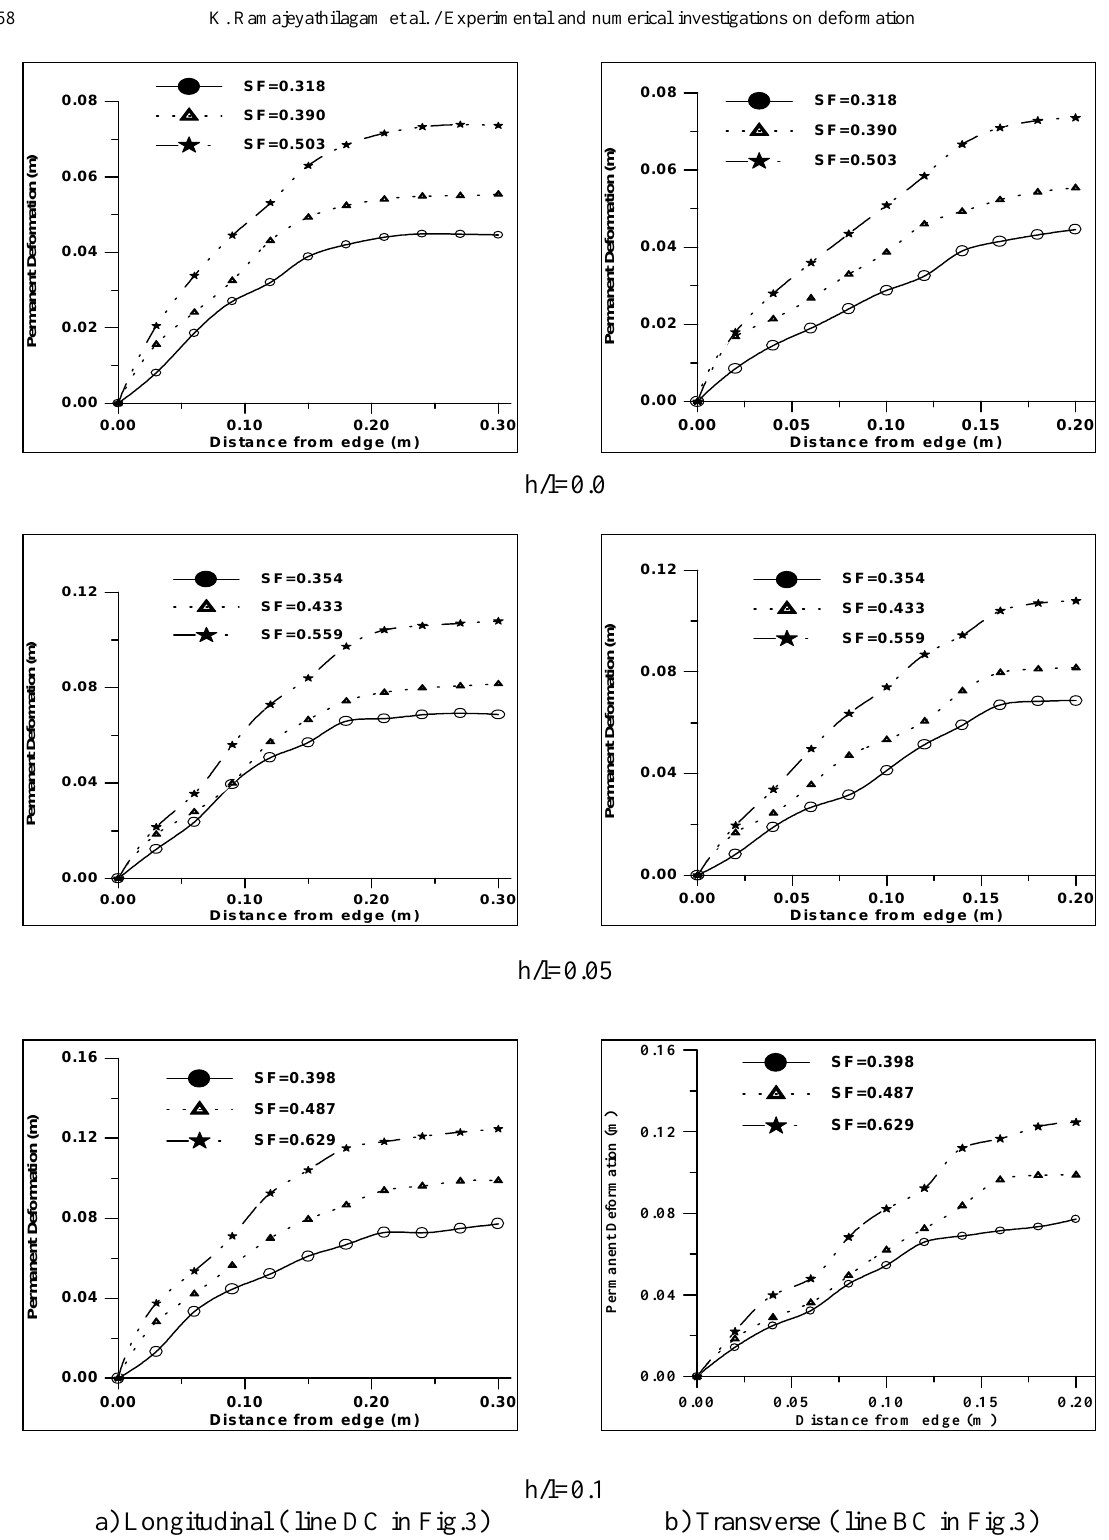
Fig. 6. Permanent deformation of the shell panel measured from the original position (Experimental) (SF = Shock